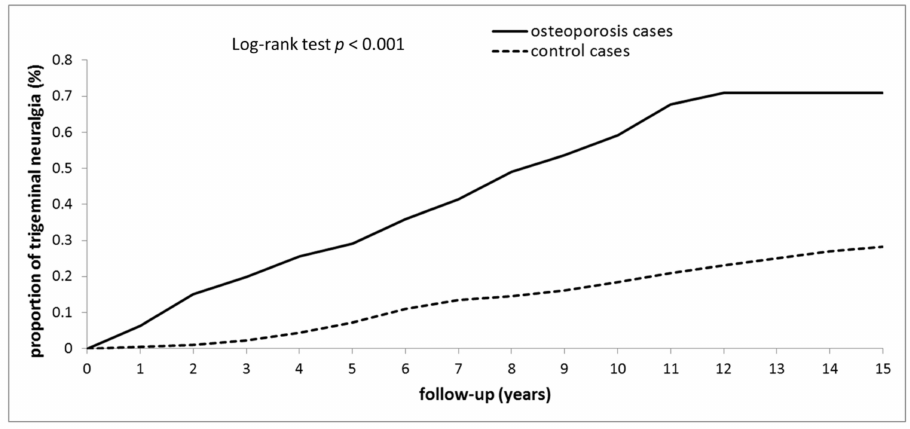
Figure 2. Cumulative incidence of trigeminal neuralgia among people with osteoporosis and controls without